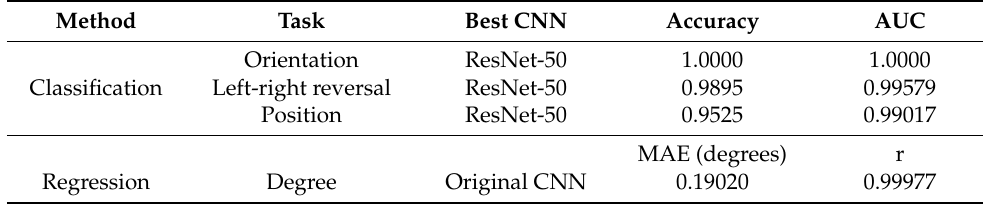
Table 2. Summary of the accuracy and area under the curve of the best-performing models.